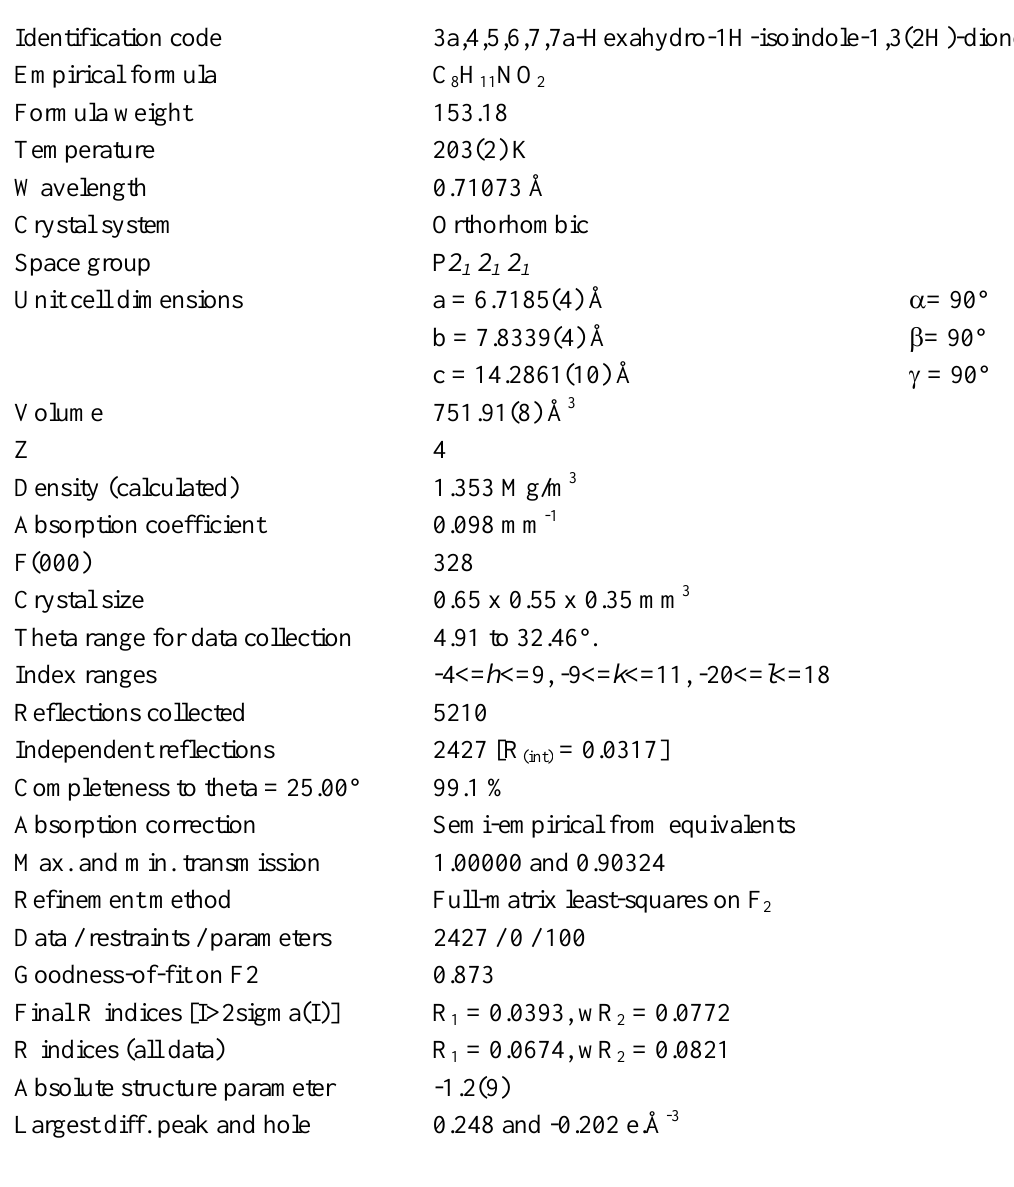
Table 1. Crystal Data for